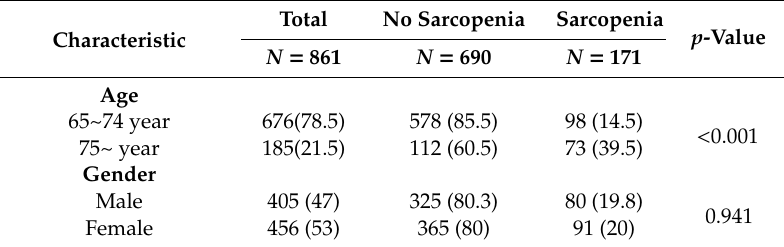
Table 1. Demographic